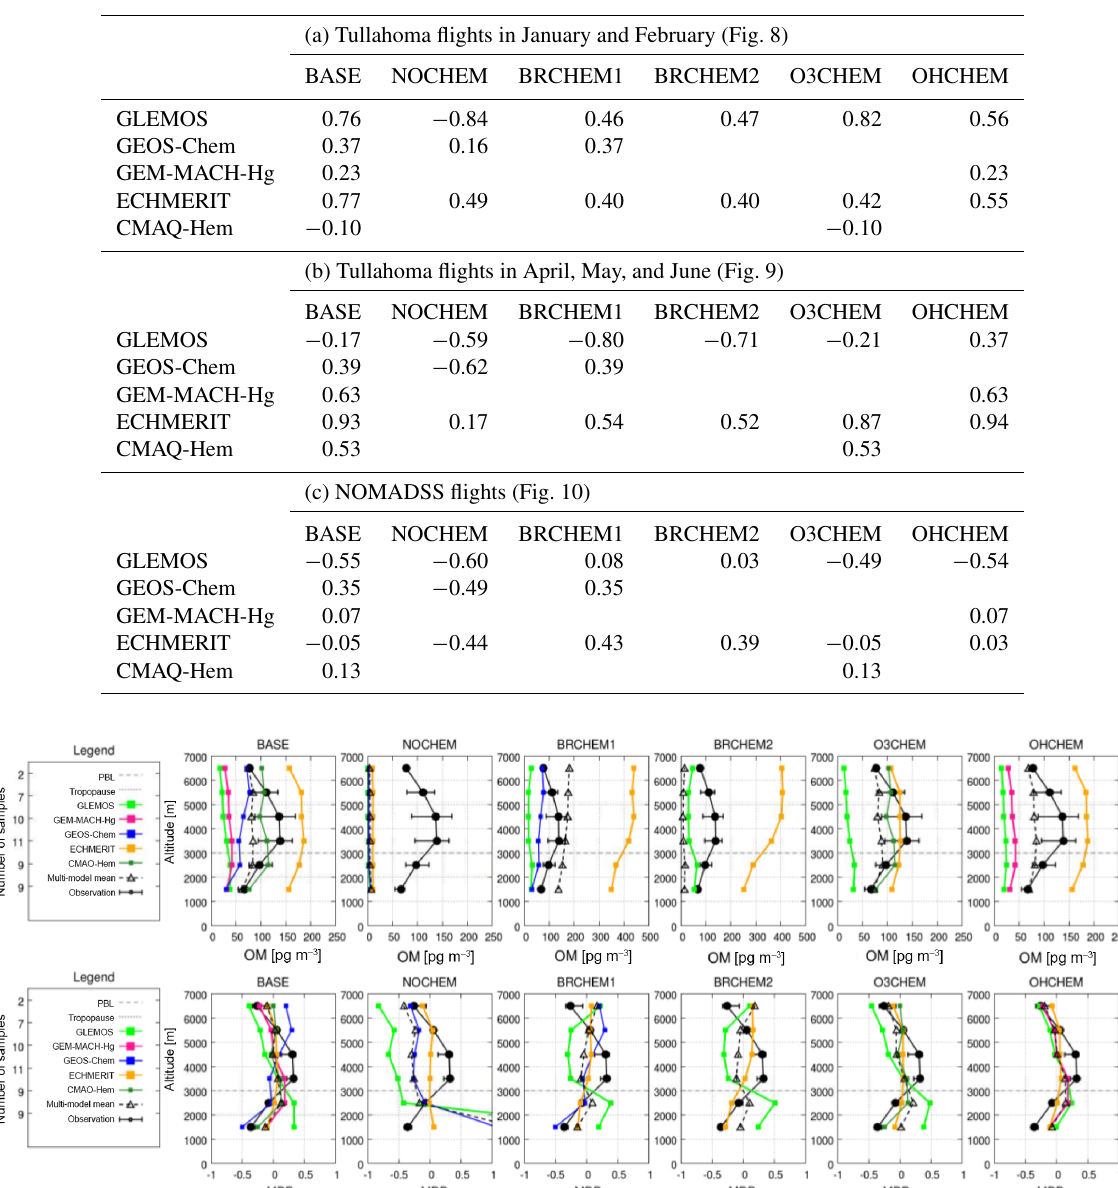
Figure 9. Comparison of average reactive mercury profiles (GOM + PBM) at Tullahoma, TN, for April, May, and June (Brooks et al., 2014). The error bars indicate the 66% quantile range of the observations in each altitude; the sample size for each altitude is indicated on the y axis of the